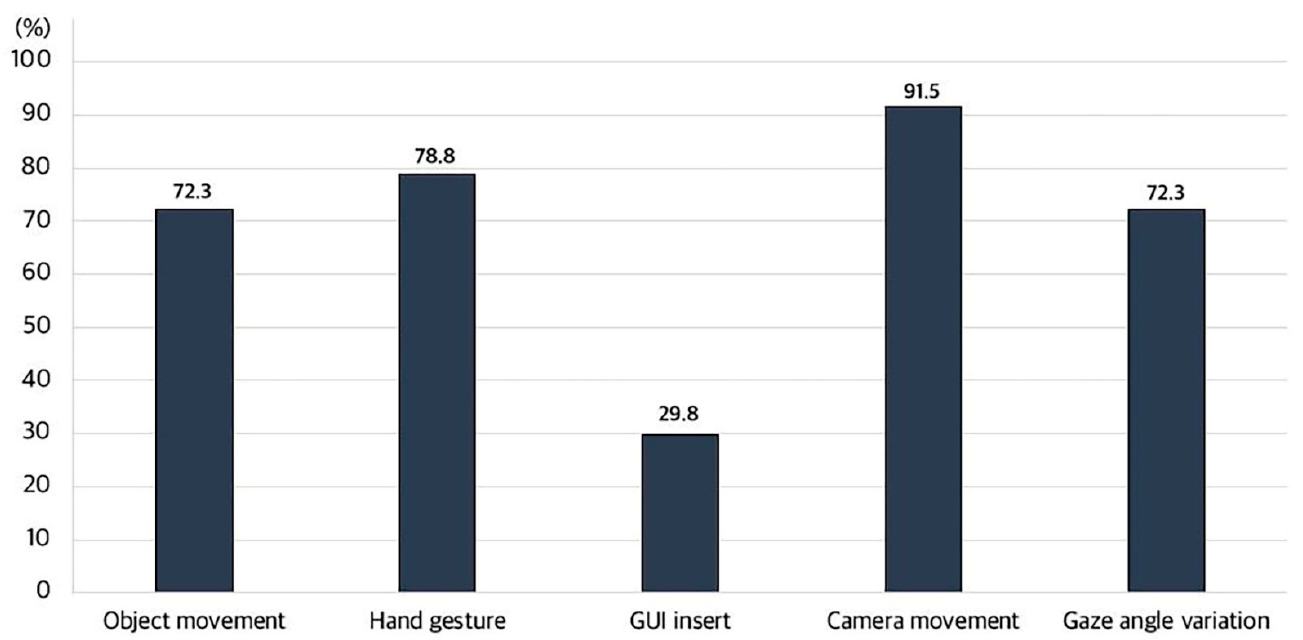
Figure 21. The 360-degree VR eye-tracking experiment results